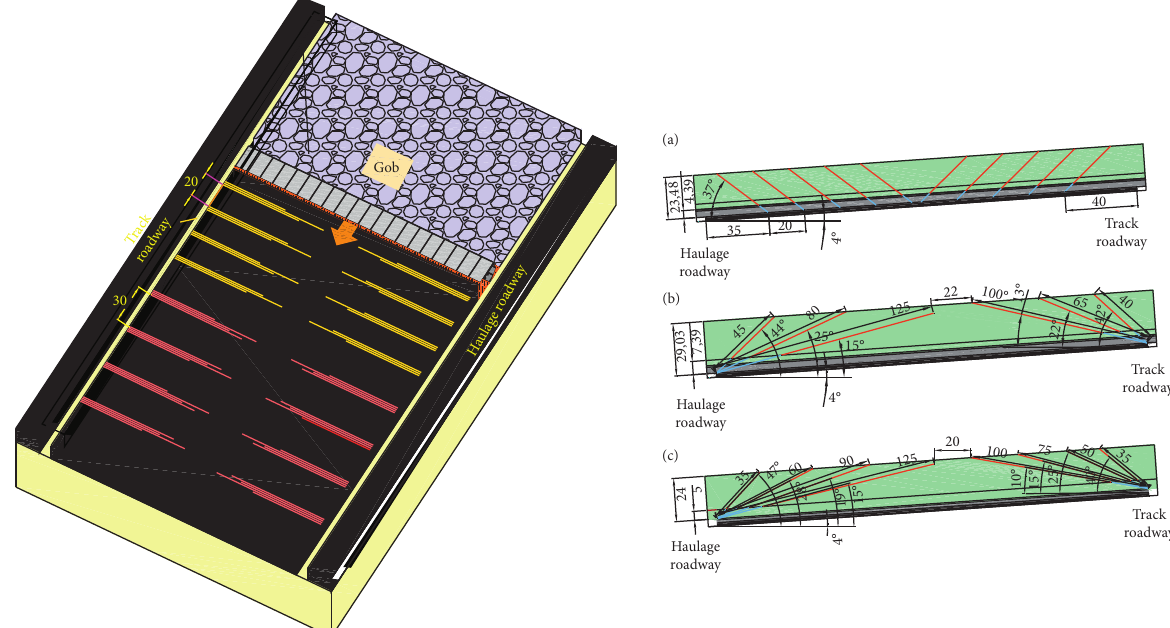
Figure 7: Layout of the blast holes in the working face of the